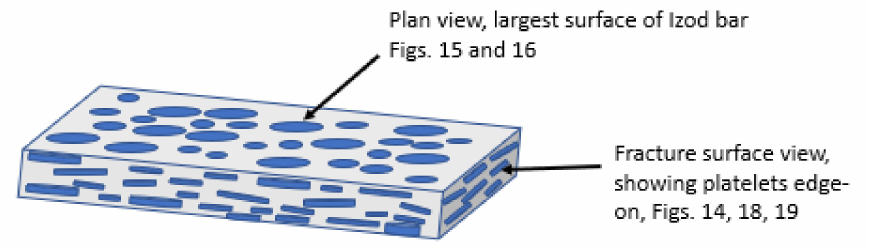
Figure 17. Schematic of orientation of Al platelets in injection-moulded Izod and flexural bars, as deduced from the SEM pictures of the fracture surface (horizontal arrow) corresponding to Figure 14, and also Figures 18 and 19, and the plan view of the bar (top arrow), whose SEM pictures are in Figures 15 and 16. The platelets are sketched, for simplicity, as disks (not to scale), although Figures 3 and 16 show they are, in fact,